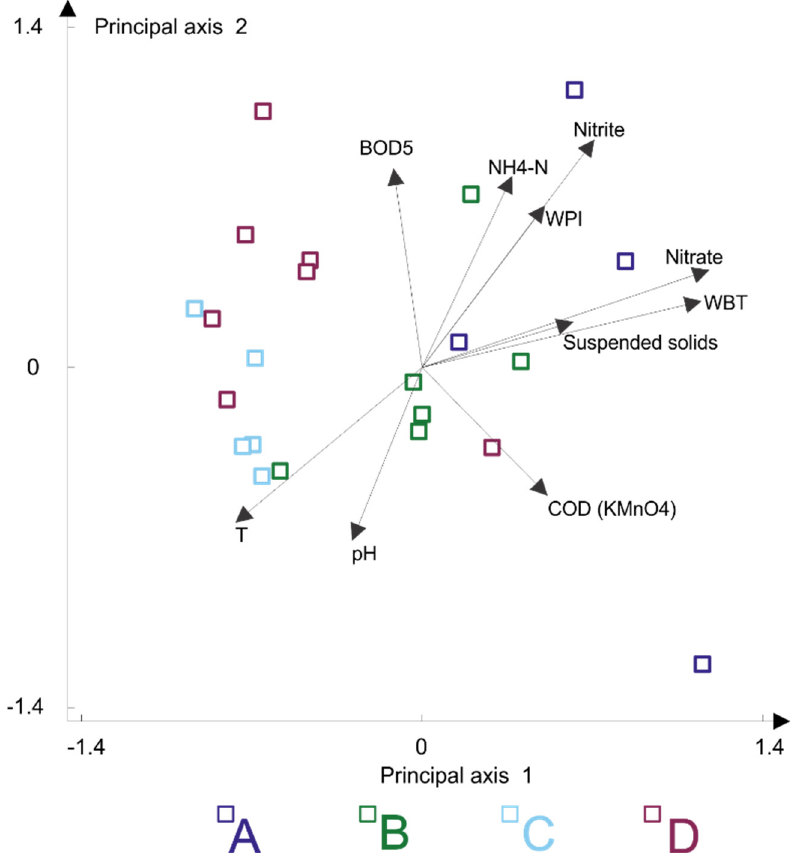
Figure 7. Canonical correspondence analysis of investigated chironomid assemblages. Four assemblage types are in capital letters A, B, C, D coloured as indicated. Nitrate, NO 3 concentration; Nitrite, NO 2 concentration; NH 4 -N, ammonium concentration; COD, chemical oxygen demand; BOD 5 , biological oxygen demand; WBT, waterbody types; WPI, water pollution index; T, water temperature.